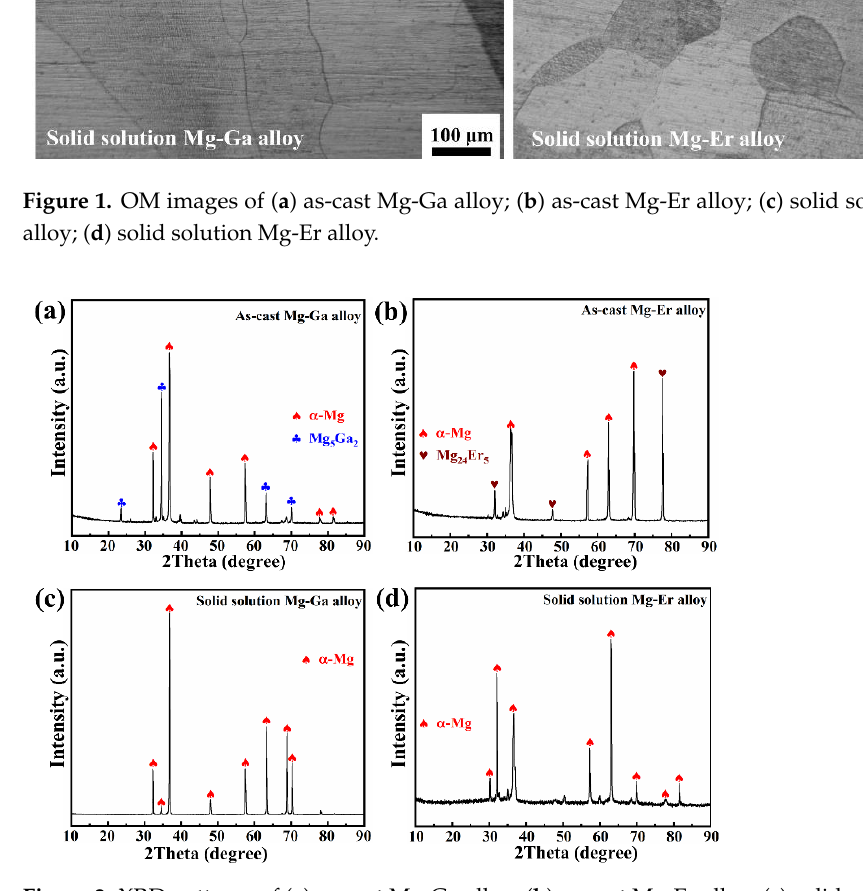
Figure 2. XRD patterns of ( a ) as-cast Mg-Ga alloy; ( b ) as-cast Mg-Er alloy; ( c ) solid solution Mg-Ga alloy; ( d ) solid solution Mg-Er alloy.